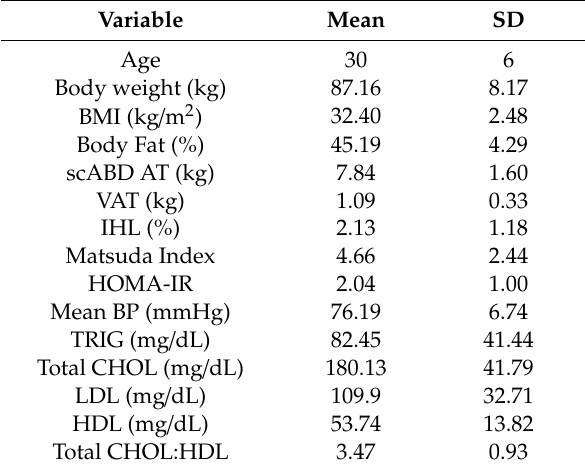
Table 1. Descriptive Statistics for Study